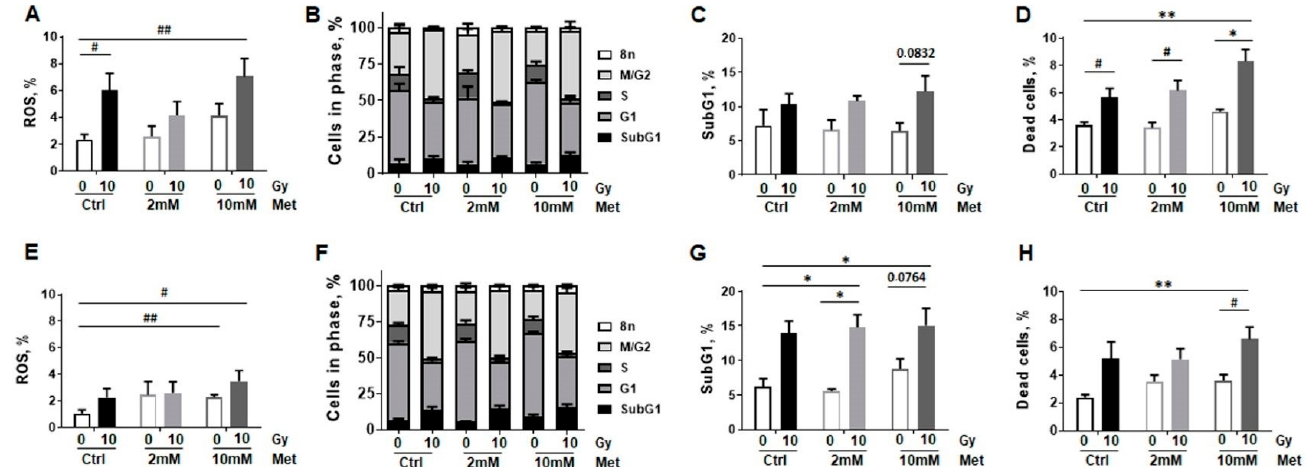
Figure 10. RT-induced cellular stress is increased upon combined metformin treatment in malignant lung epithelial cells. ( A , E ) NCI-H460 and A549 lung tumor cells were analyzed concerning reactive oxygen species (ROS) production at 24 h of post RT and metformin treatment using dihydroethidium (DHE) staining in combination with flow cytometry analyses. Data are shown as mean values ±SEM of 5–7 independent experiments. Statistics were analyzed by unpaired (two-tailed) t -tests, indicating: # p ≤ 0.05 and ## p ≤ 0.01. p -value indicates: ** p ≤ 0.01 by two-way ANOVA with post hoc Tukey’s multiple comparison test. ( B , F ) Respective cell cycle analysis at that time point were estimated following Nicoletti staining. Data were summarized as mean values ± SEM of 3 independent experiments. ( C , G ) Cell death rates were further determined by exclusion propidium iodide staining. Data show mean values ±SEM of 3 independent experiments. p -values indicate: * p ≤ 0.05, ** p ≤ 0.01 two-way ANOVA with Tukey’s multiple comparison test. Unpaired (two-tailed) t -tests are additionally indicated: # p ≤ 0.05. ( D , H ) Total cell death levels were determined by propidium iodide exclusion staining using flow cytometry. Data are summarized as mean values of 3–5 independent experiments. p -value indicate: * p ≤ 0.05, ** p ≤ 0.01 by two-way ANOVA with Tukey’s multiple comparison test. Unpaired (two-tailed) t -tests are additionally indicated: # p ≤ 0.05.